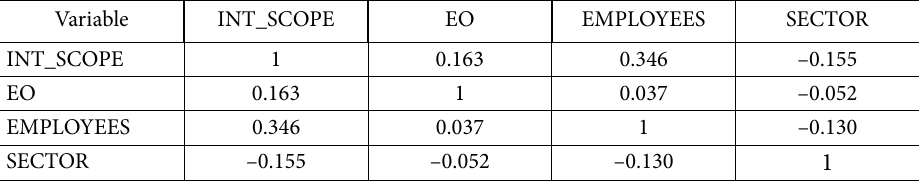
Table 3. Correlation matrix for control and independent variables (source: own calculations based on a survey ( n = 355))